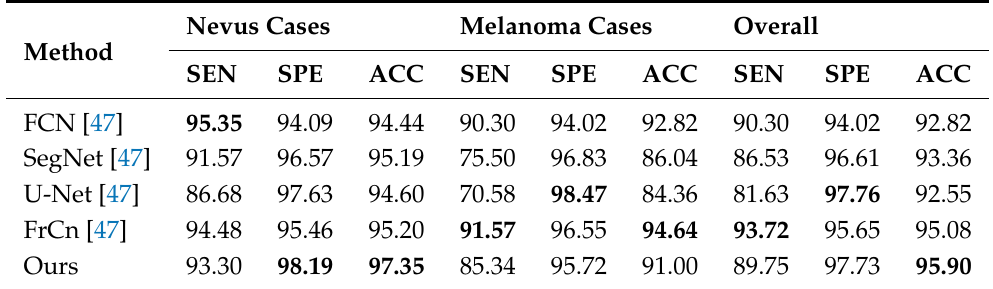
Table 12. Performance evaluation of sensitivity, specificity, and accuracy performance of different attention modules and CSFAG modules on the ISIC-2017 data set using baseline as the basic structure. Bold data indicates that the value is the maximum value in this indicator.